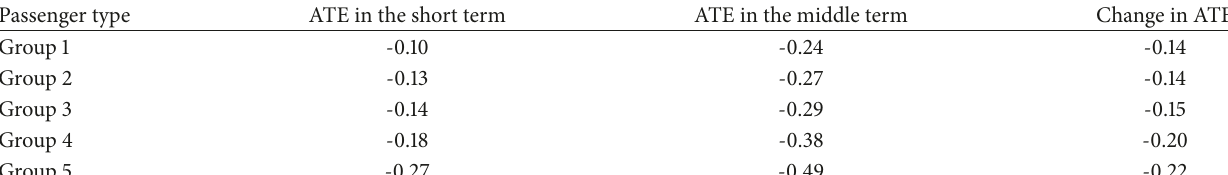
Table 8: ATE of different passenger types in different time ranges.